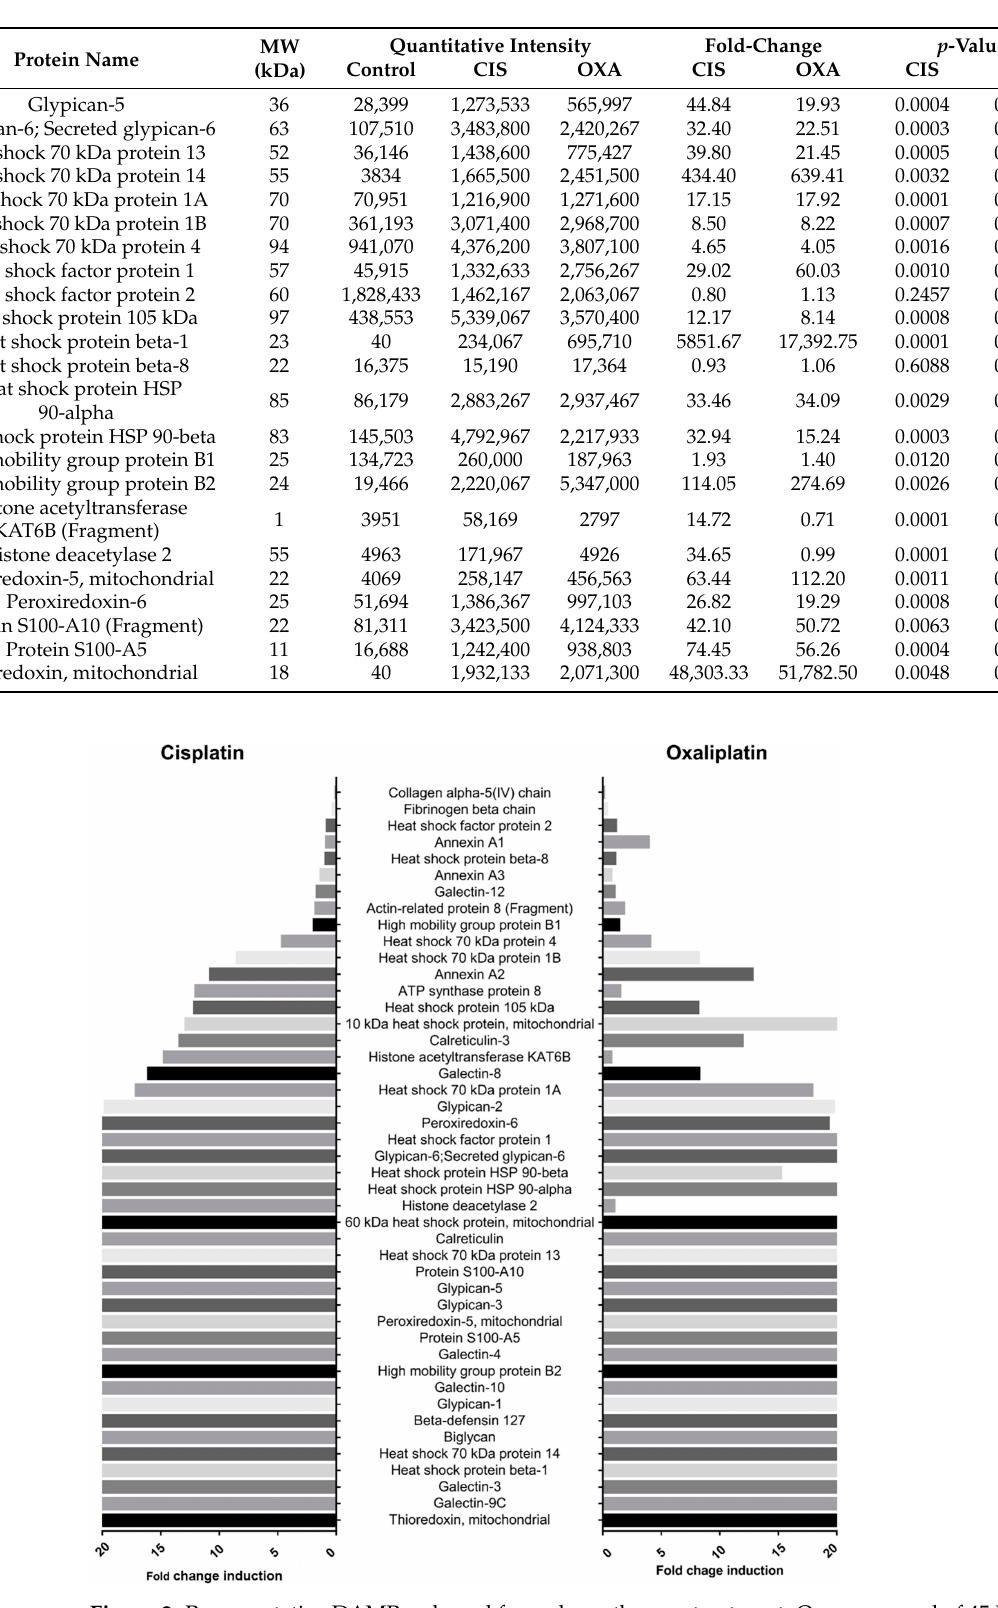
Figure 2. Representative DAMPs released from chemotherapy treatment. Overexpressed of 45 DAMPs were investigated by short-gun proteomic and plotted against fold induction, which compared cisplatin and oxaliplatin treatment.